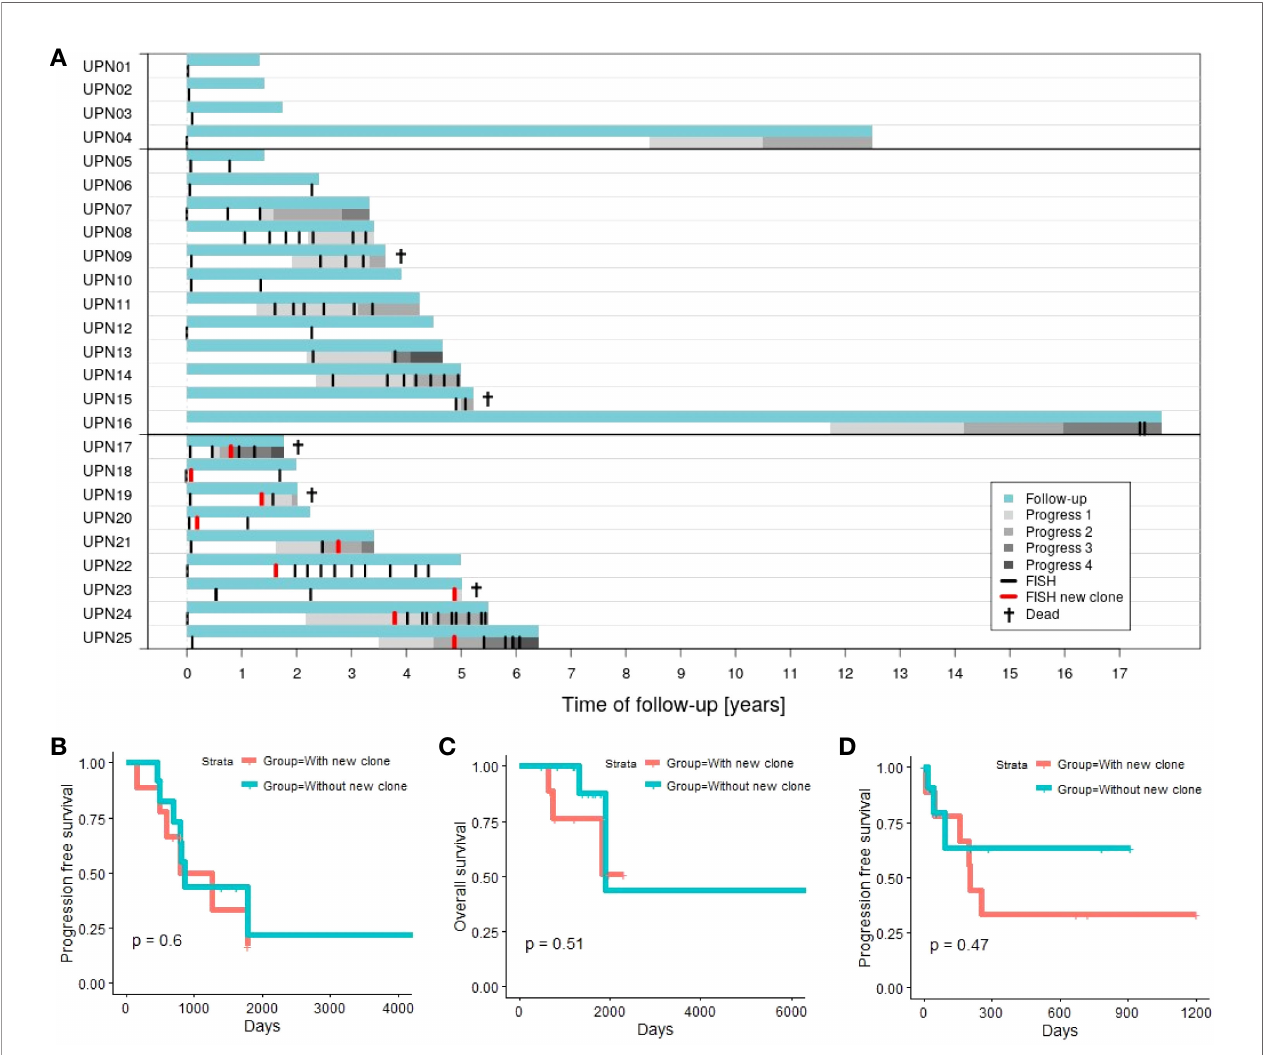
FIGURE 1 | (A) Time of follow-up for patients with 1 time point of aberration analysis (patients UPN01 to 04), patients with >1 time point of aberration analysis and no new clone emerging in the course of disease (patients UPN05 to 16; subgroup 1), and patients with >1 time point of aberration analysis and a new clone emerging in the course of disease (patients UPN17 to 25; subgroup 2). (B) Progression-free survival ( fi rst progression after fi rst diagnosis) comparing subgroup 1 vs. subgroup 2. (C) Overall survival comparing subgroup 1 vs. subgroup 2. (D) Progression-free survival in relation to chromosomal alterations comparing subgroup 1 (next progression subsequent to last FISH) vs. subgroup 2 (next progression subsequent to detection of the new